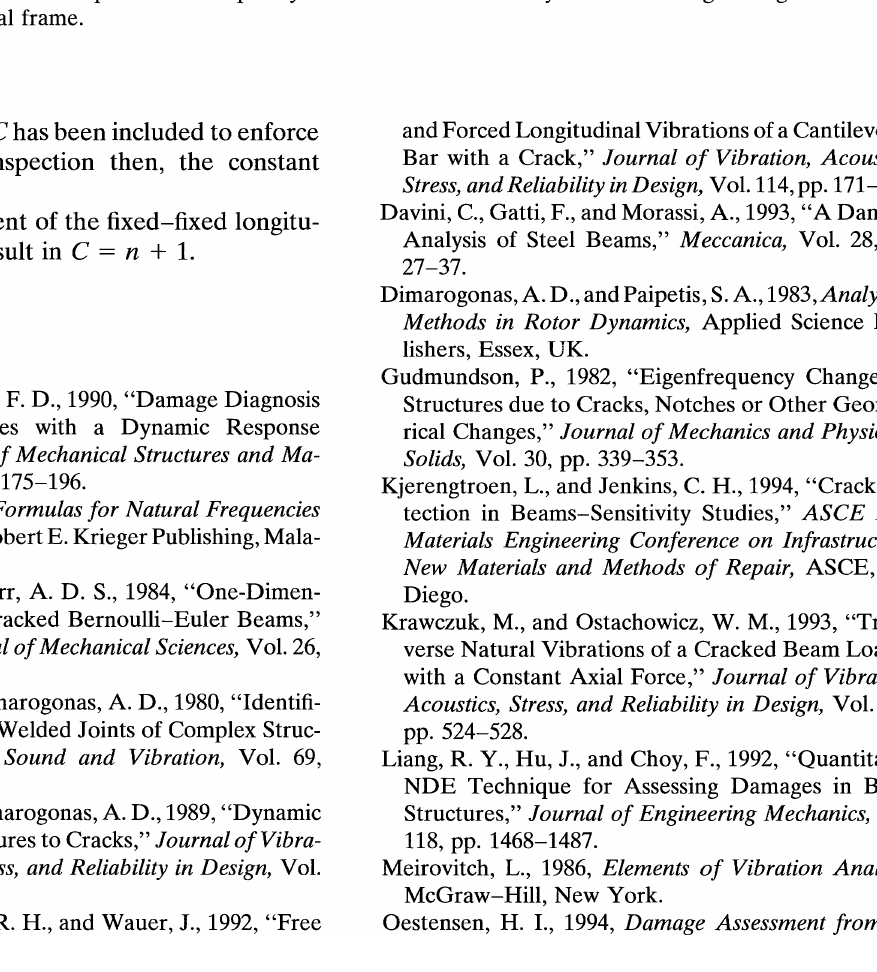
FIGURE 11 Comparison of frequency and deflection sensitivity with increasing damage for a portal